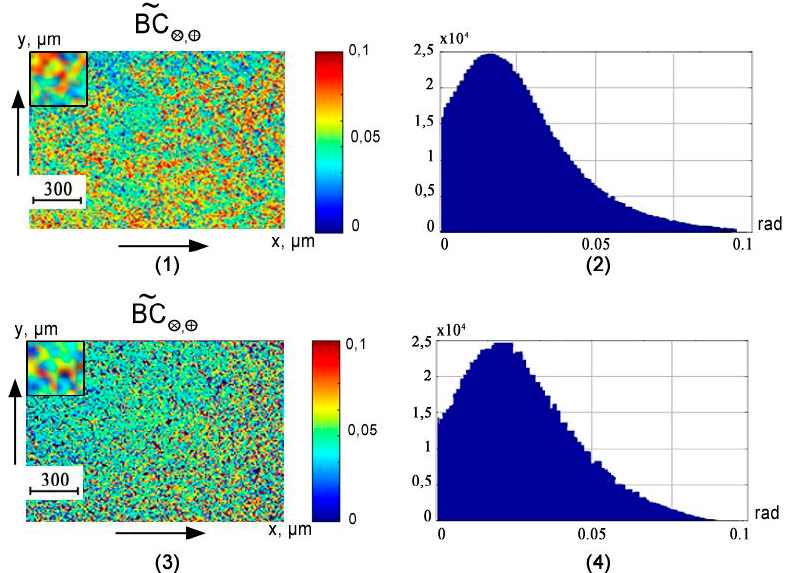
Figure 4. An example of maps and histograms of the DT red spatial distribution fluctuations of the (cid:16) (cid:17) ( ) B (cid:101) L 45 ; 135 linear birefringence of polycrystalline blood films taken from healthy donor (( 1 ) and ( 2 )) and cancer patient (( 3 ) and ( 4 )).